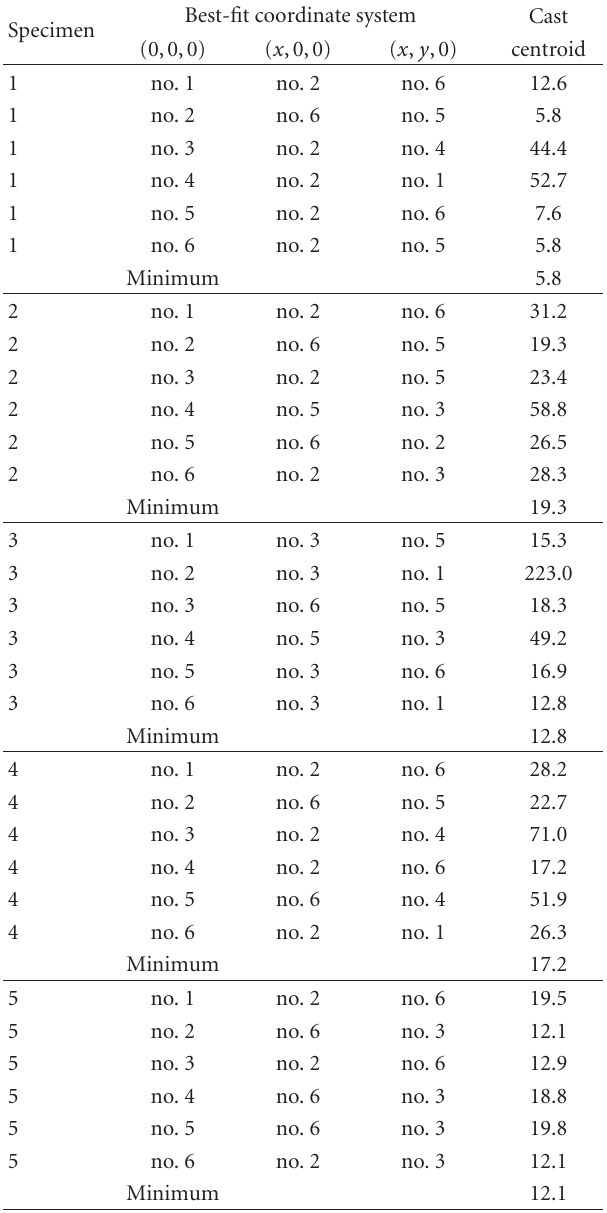
Table 1: The best-fit matching results in µ m of the cast frameworks to their respective master casts using the fixed method of alignment. 0,0,0 represents the matching centroid position, x ,0,0 and x , y ,0 represent the best fit centroids for that position. The final column is the mean vertical gap at that position centroid.